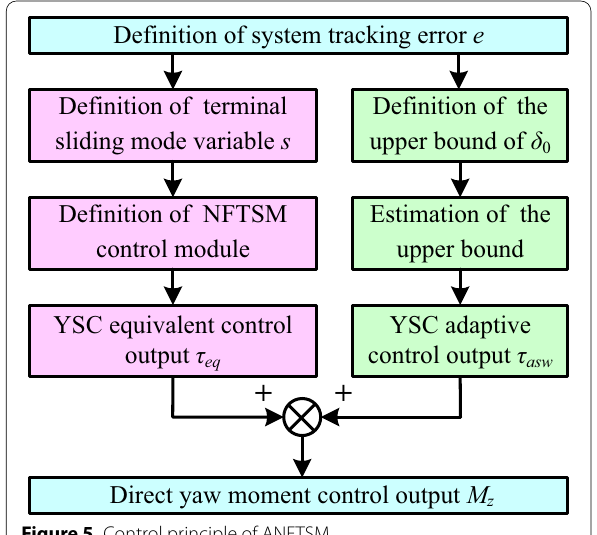
Figure 5 Control principle of